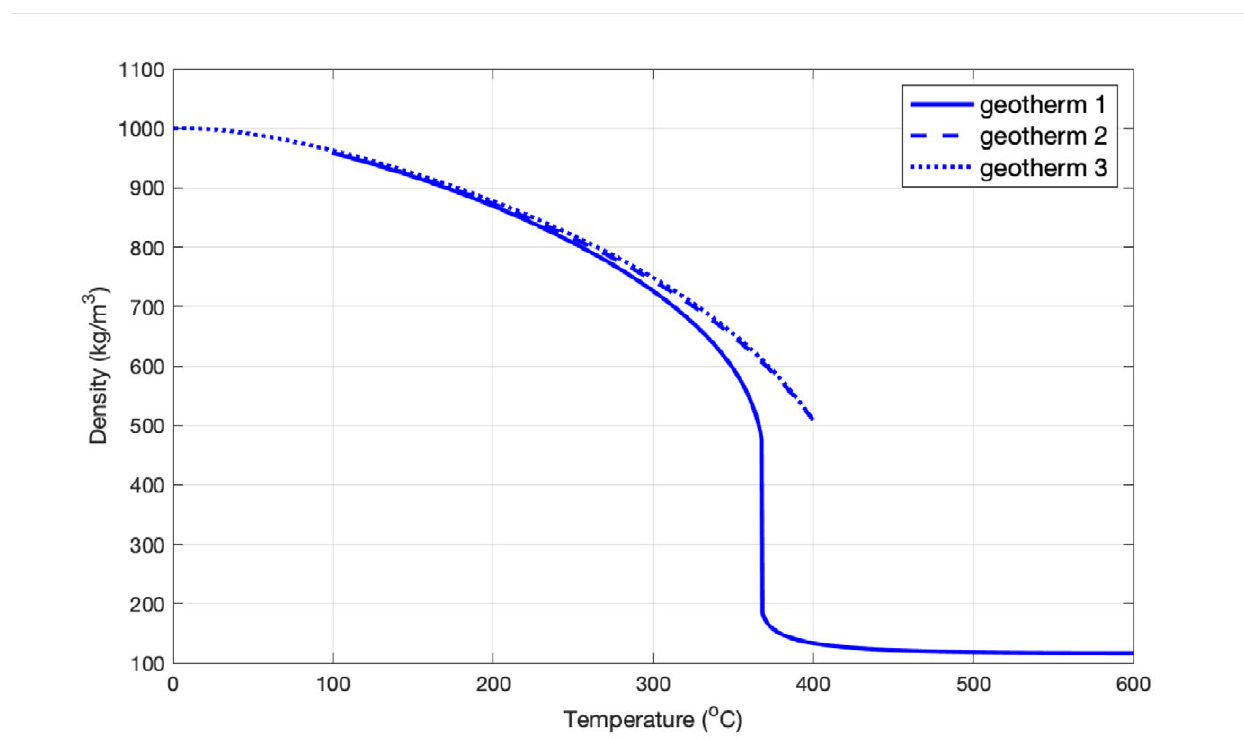
Figure D5: Density of water as a function of temperature for 3 different linear geotherms. Geotherm 1 starts at the surface (1 atm) and 100 °C and ends at a depth of 1500 m and 600 °C. Geotherm 2 starts at 1 atm and 100 °C and ends at 1500 m depth and 400 °C. Geotherm 3 starts at 1 atm and 0 °C and ends at 1500 m depth and 400 °C. Data from Parry et al. [2000], using the MATLAB functions published by Mikofski [2013].